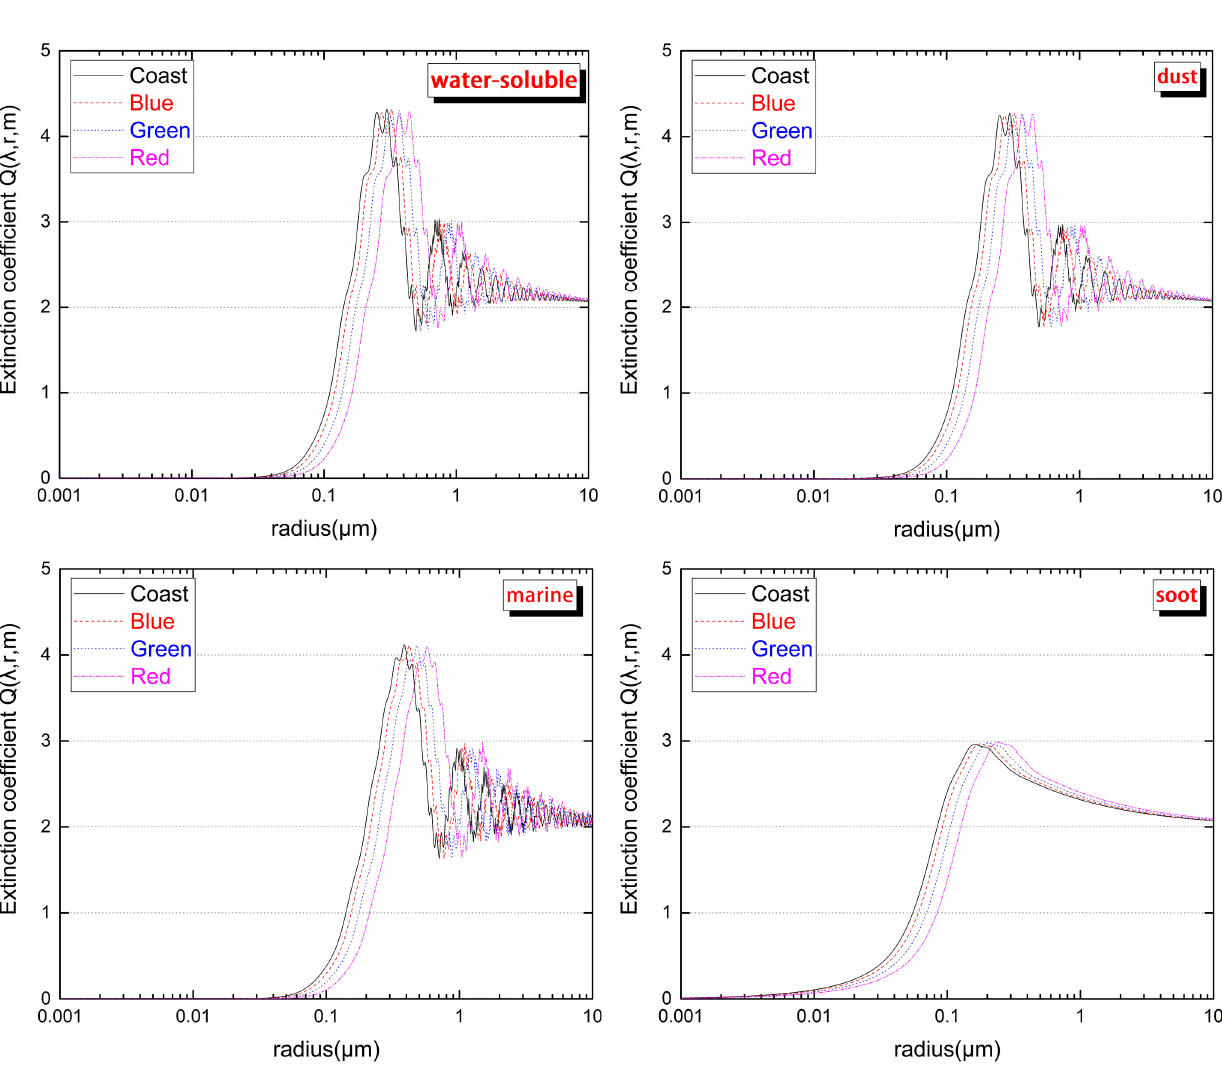
Figure 5. The extinction coefficient of different aerosol particles at different bands.